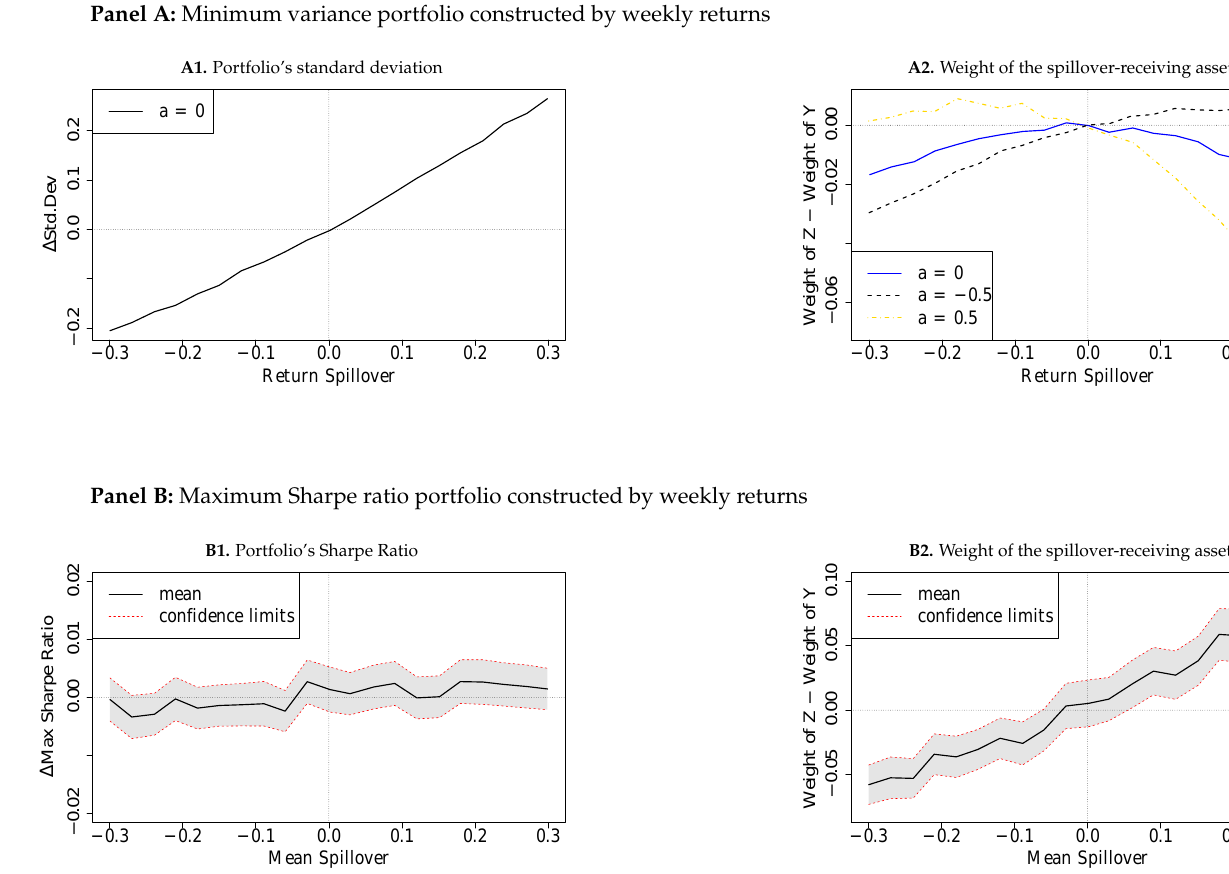
Figure 6. Return spillovers and portfolio optimization using lower frequency returns. This figure presents the differences in characteristics of optimal portfolios formed by weekly returns with and without daily returns spillover. We use “daily” and “weekly” for the illustration purpose; the results also apply to other relative “high” and “low” frequencies. Panel A presents the differences in the standard deviation and in the weight of the spillover-receiving asset in the minimum variance portfolios. Panel B presents the differences in the Sharpe ratio and in the weight of the spillover-receiving asset of the portfolios targeting maximum Sharpe ratio. Shaded areas represent confidence intervals. Confidence intervals in Panels A1 and A2 are not shown because they are very close to the mean. In all figures except A2, for brevity, we only present the graphs with a = 0. The graphs with a = − 0.5 and a = 0.5 are